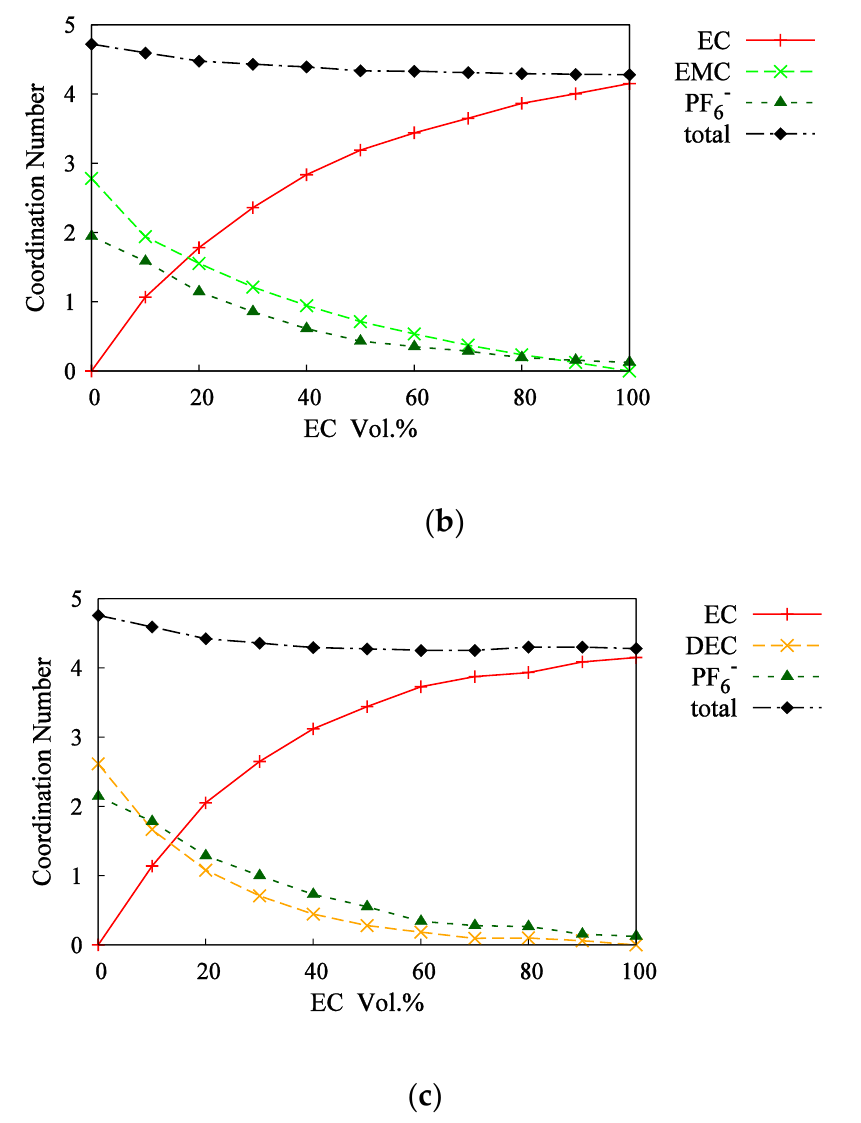
Figure 10. Estimation of the solvation shell about Li+ in mixed electrolytes. ( a ) EC + DMC + 1M-LiPF 6 ;